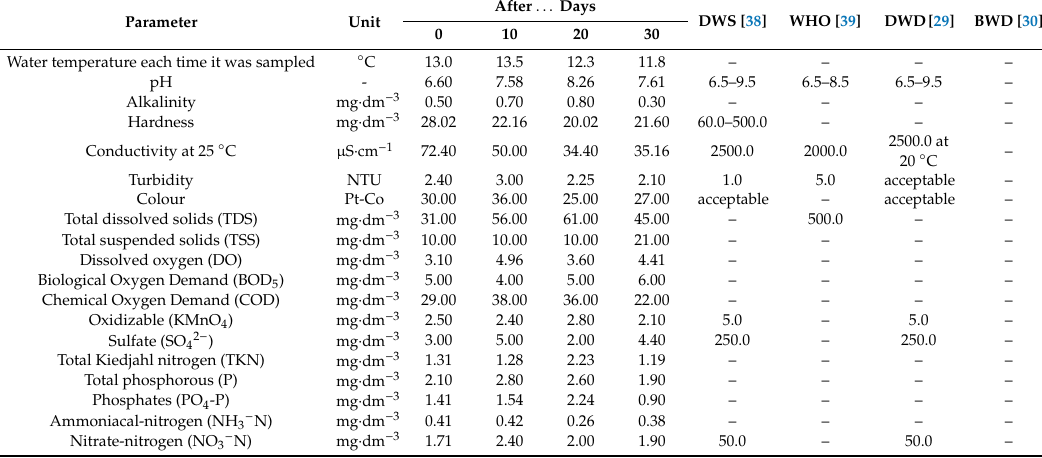
Table 1. Physicochemical characteristics of rainwater (cement tile roof) in comparison with Polish drinking water standards (DWS) [38], World Health Organization guidelines for drinking water quality (WHO) [39], EU Drinking Water Directive (DWD) [29] and EU Bathing Water Directive (BWD)